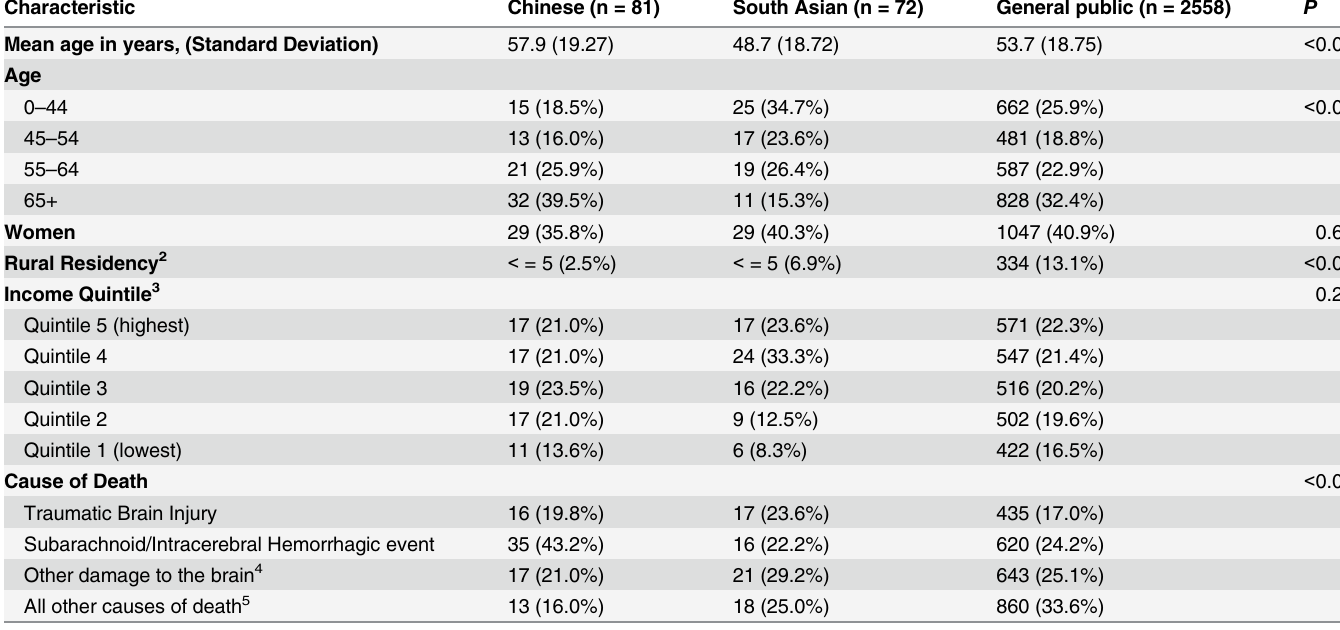
Table 3. Baseline characteristics of decedents whose family was approached for organ donation 1 (Cohort